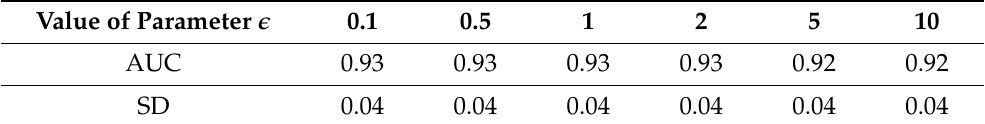
Table 11. Performance of the proposed method (mean AUC and standard deviation) on ECG tensors as the regularization parameter (cid:101) varies.